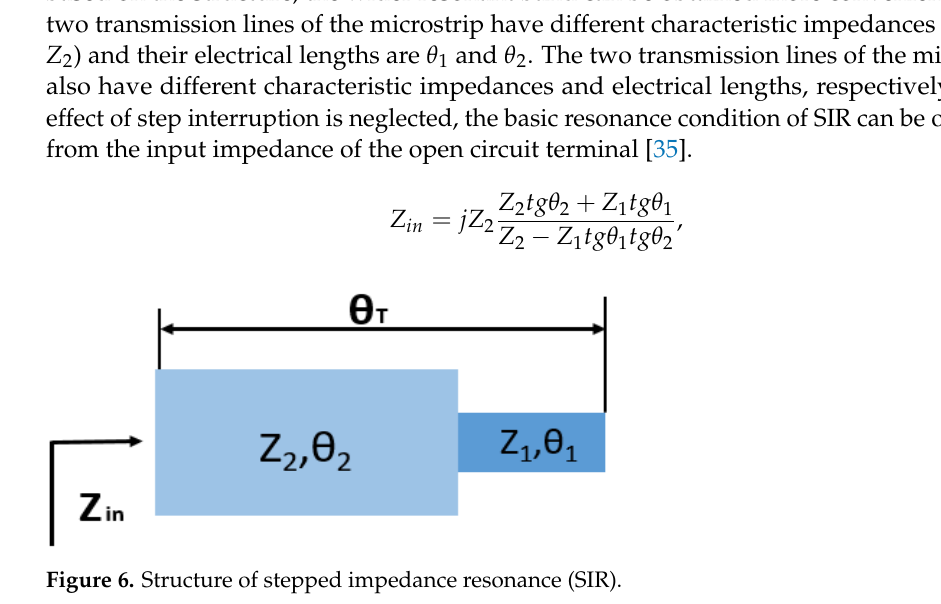
Figure 6. Structure of stepped impedance resonance (SIR).